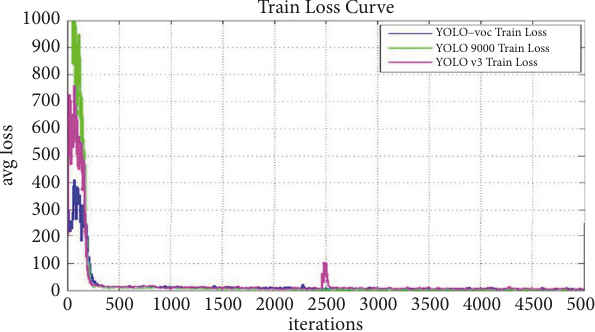
Figure 9: Loss curve of synchronous flow.